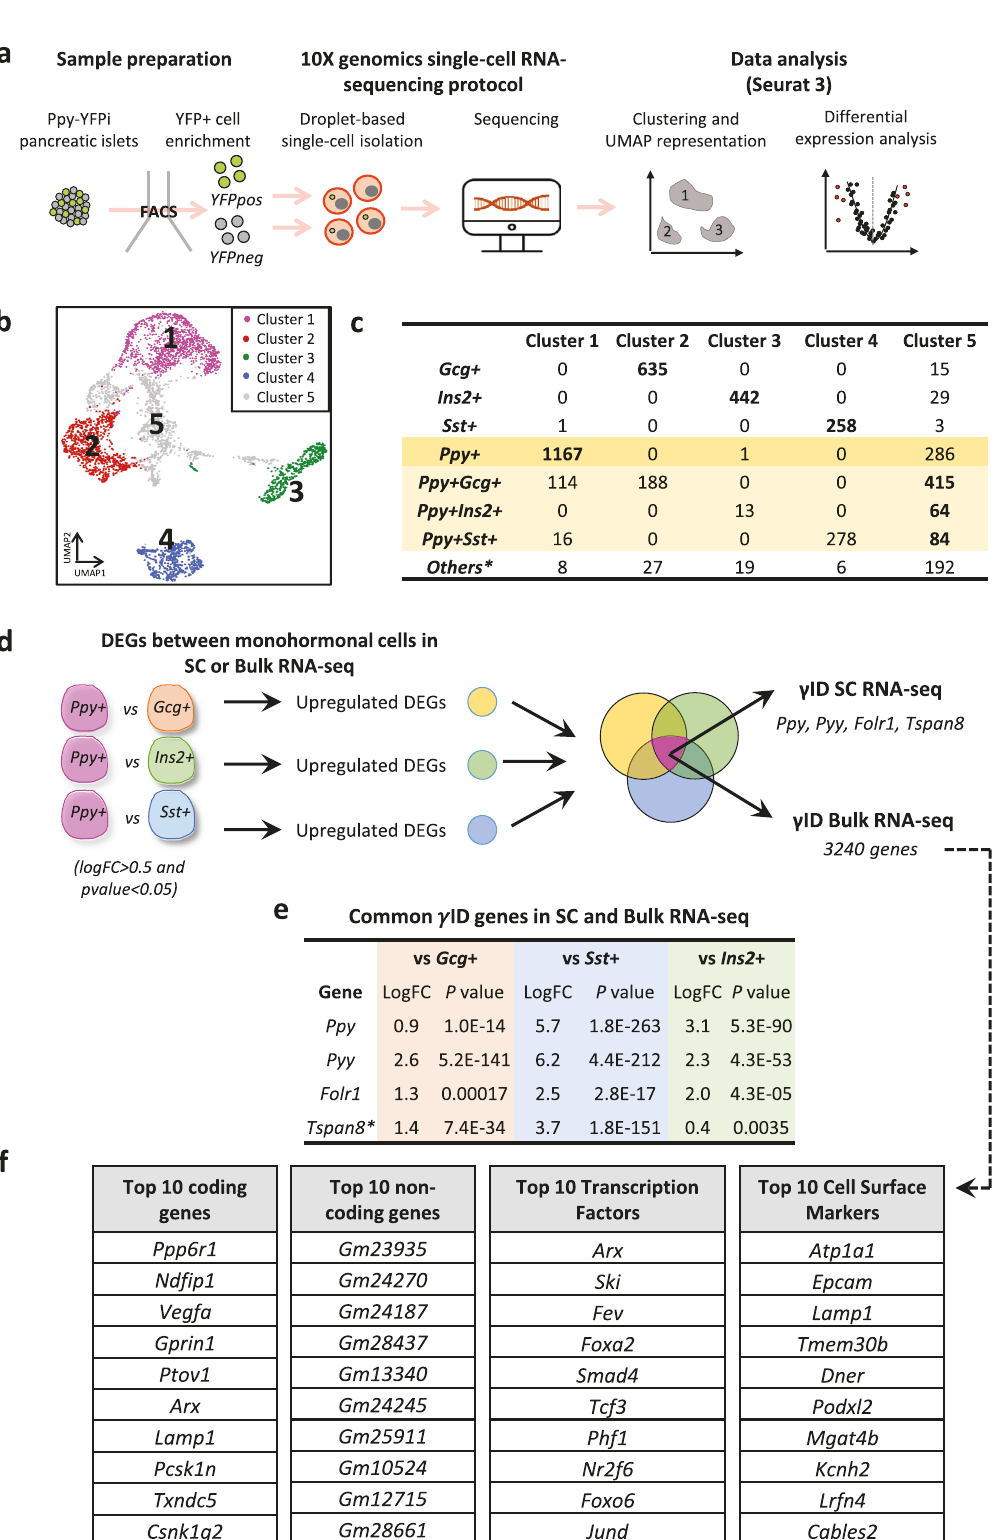
hormones were de fi ned as bihormonal (Supplementary Fig. 7; Source Data g). UMAP dimensional reduction showed that Ins2 -, Gcg -, Sst - and Ppy -expressing cells were distributed in four main clouds with overlapping regions mainly where Ppy expression is located (Supplementary Fig. 7). Of note, the distribution of the YFP + cell fraction tightly correlated with the Ppy + cell localiza- tion (Supplementary Fig. 7). Only the hormone-expressing